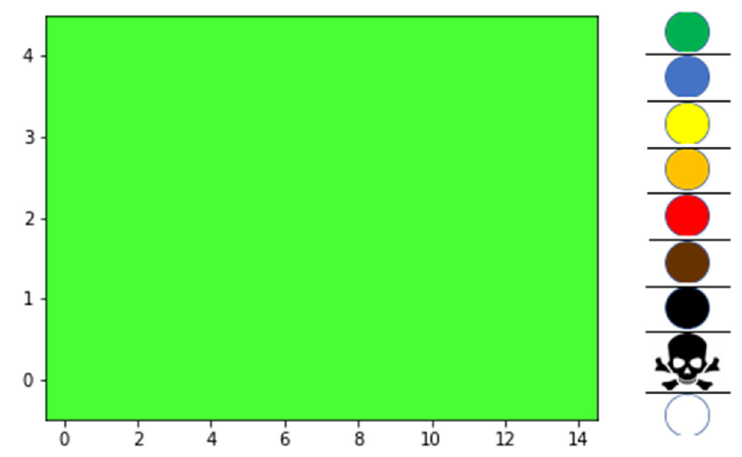
Figure 7. SOW estimation of each of the battery modules in the battery system.